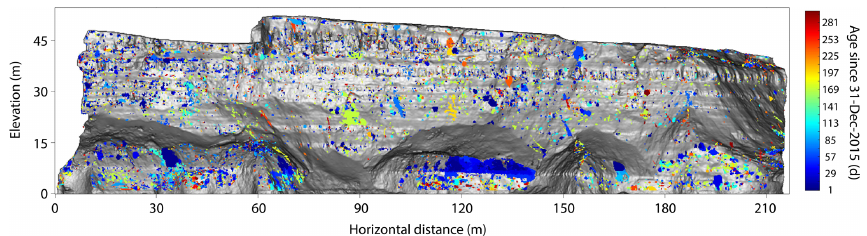
Figure 11. Distribution of rockfalls across East Cliff monitored at sub-hourly intervals between 5 March and 30 December 2015. Rockfalls are distributed across the entire cliff face, in particular in areas of exposed bedrock. Although the high water mark is below the portion of cliff shown in this figure, the largest and most frequent rockfalls occur at the base of the cliff. Accumulation and loss of material in the areas of unexposed bedrock on the cliff buttresses, which runs across the cliff face at ∼ 17m elevation, were removed. Colours represent the age since 31 December, where red represents the oldest rockfall.